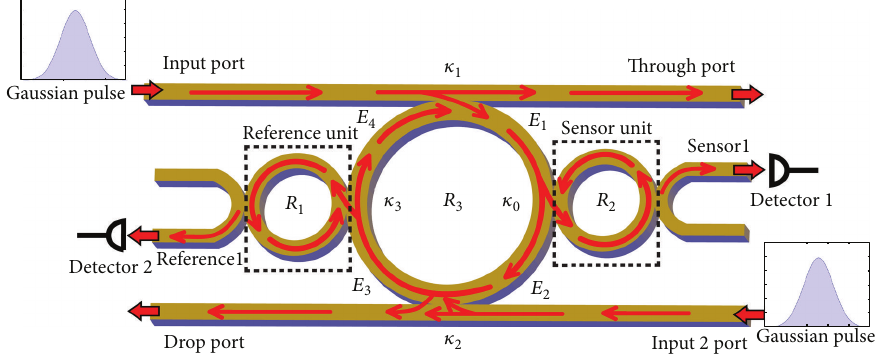
Figure 1: Schematic diagram of a microforce sensing using PANDA ring resonator and deformation shape of sensing ring within the sensing unit with and without external force, where 𝑅 𝑠 is ring radii, 𝜅 𝑠 is coupling constant, and 𝐸 𝑠 is optical fields.